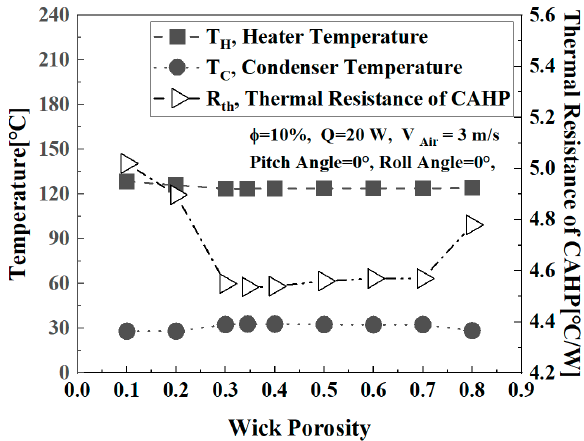
Figure 14. Simulated thermal characteristics of the CAHP according to wick porosity ( V air = 3 m/s, Q = 20 W, pitch angle = 0°, and roll angle = 0°).